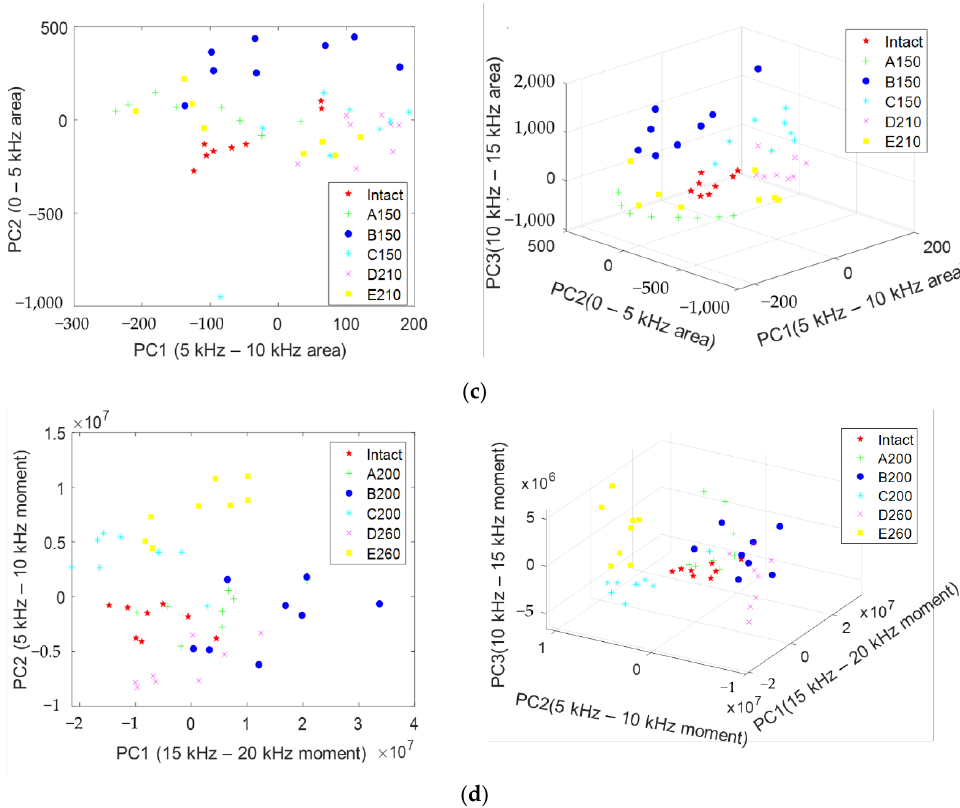
Figure 15. PCA results for defect type and depth. ( a ) Feature set (d50). PC1: 5 – 10 kHz moment, PC2: 0 – 5 kHz moment,